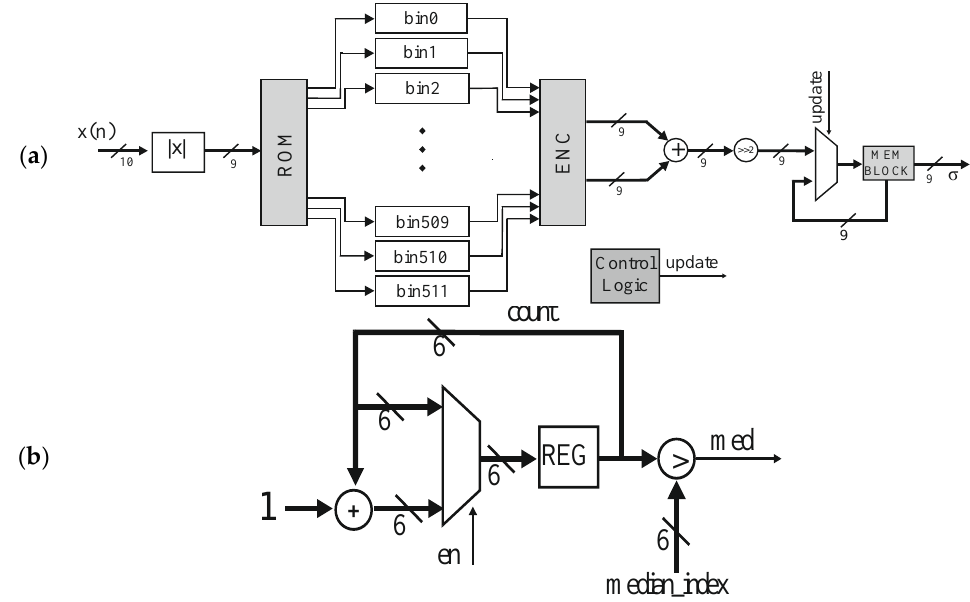
Figure 8. MAD structure: ( a ) Cumulative histogram of the median operator and ( b ) bin structure. Table 2. Post-physical synthesis consumptions of noise approaches candidates: MAD and our three- point median based method.